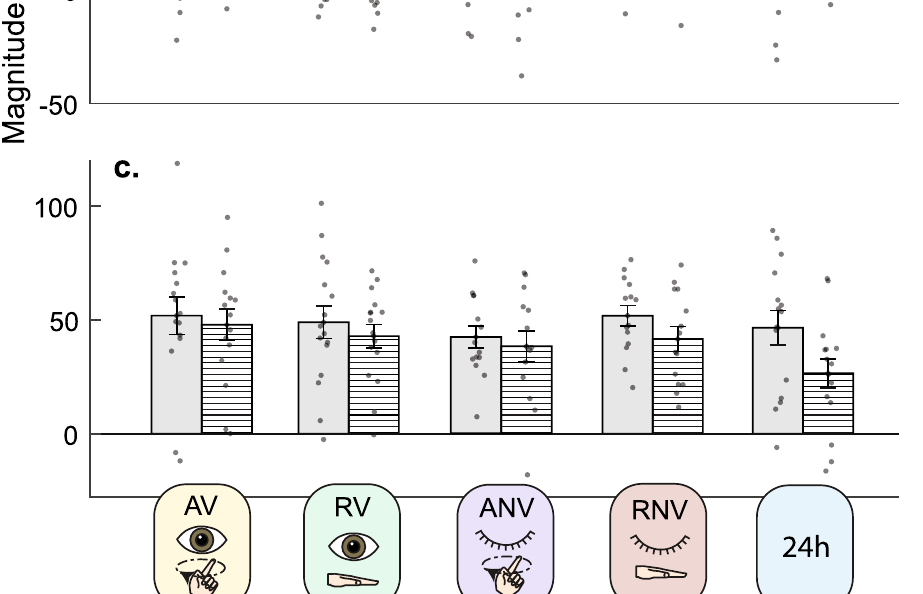
of group (F 4,68 = 1.26, p = 0.30, η p2 = 0.07). One-sample t-tests indicated that the total retention was significantly